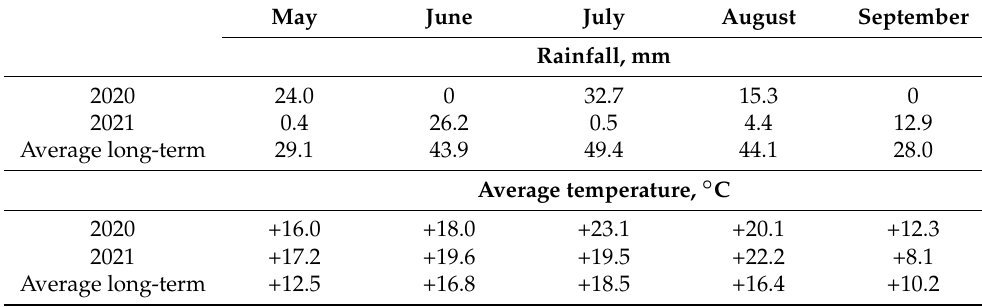
Table 2. Climatic factors in the experimental field during two cropping seasons